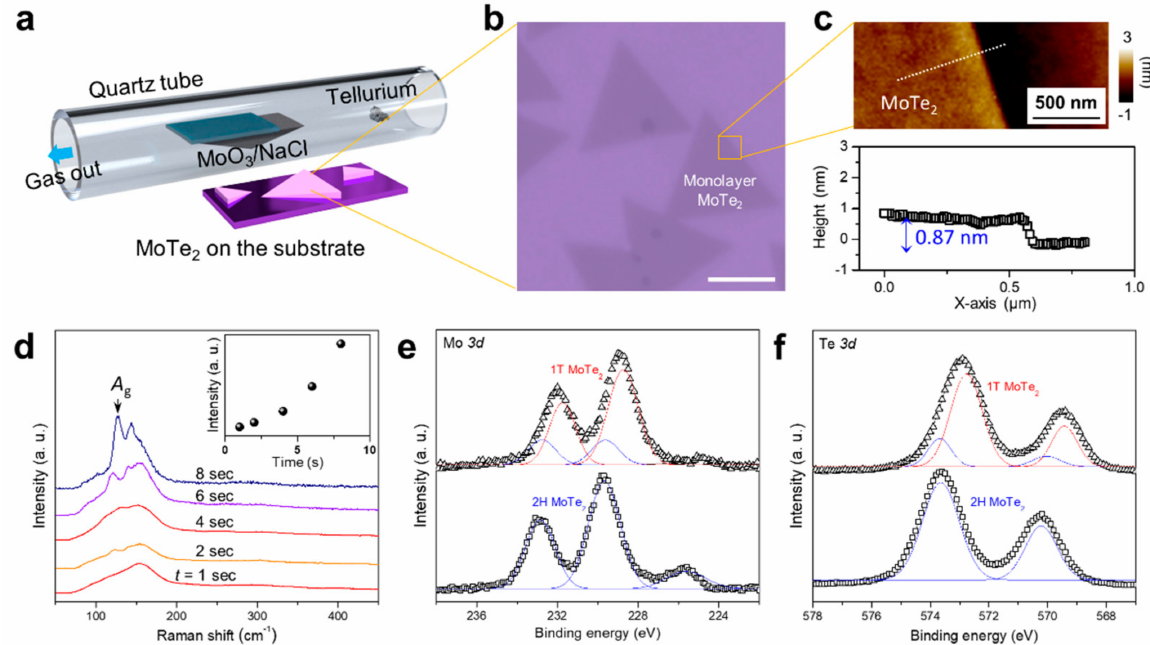
Figure 1. Characterization of CVD-grown MoTe 2 : ( a ) Schematic of CVD synthesis of MoTe 2 on SiO 2 /Si substrate using salt-assisted growth; ( b ) Optical microscopy image of triangular monolayered MoTe 2 nuclei on the SiO 2 /Si substrate. The scale bar is 2 µ m; ( c ) AFM image of MoTe 2 and the height profile corresponding to the white dashed line; the thickness of the MoTe 2 is 0.87 nm; ( d ) Raman spectra of MoTe 2 at various laser irradiation times. The inset shows the evolution of the Ag peak related to the 1T (cid:48) phase of MoTe 2 with time. XPS spectra show ( e ) Mo 3 d and ( f ) Te 3 d peaks of the 1T (cid:48) and 2H phases of MoTe 2